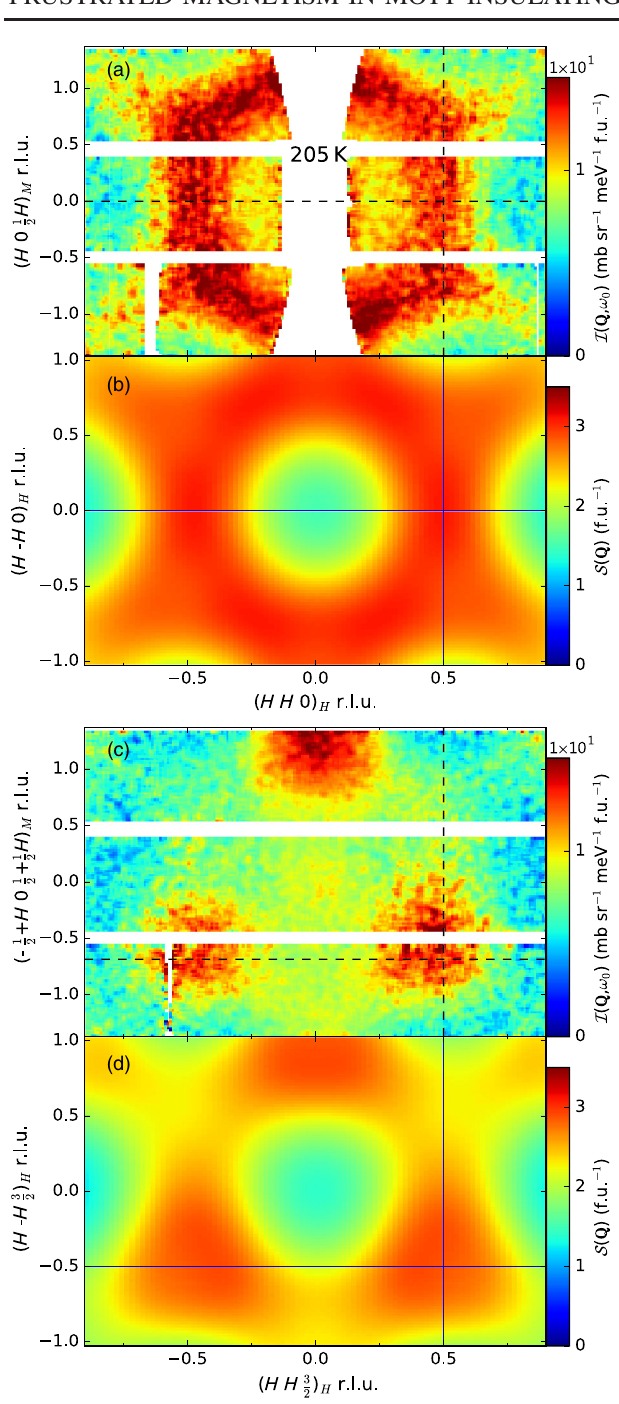
FIG. 4. (a),(c) Inelastic neutron scattering intensity from ð V Þ ℏ ω ¼ 7 . 5 meV (averaging range ¼ 0 . 96 Cr 0 . 04 0 2 O 3 at 205 K at ½ 5 ; 10 (cid:2) meV) for wave vector transfer within pseudohexagonal basal planes (as in Fig. 2) at offsets along the pseudohexagonal ¼ 0 (a),(b) and L ¼ 1 . 5 (c),(d). (b),(d) These c axis of L H H experimental data are compared with the calculated dynamic spin-correlation function S ð Q Þ obtained with the complete set of DFT calculated exchange constants of the PI phase for ð V Þ 0 . 96 Cr 0 . 04 2 O 3 given in Table II. Lines indicate positions of cuts shown in Fig.